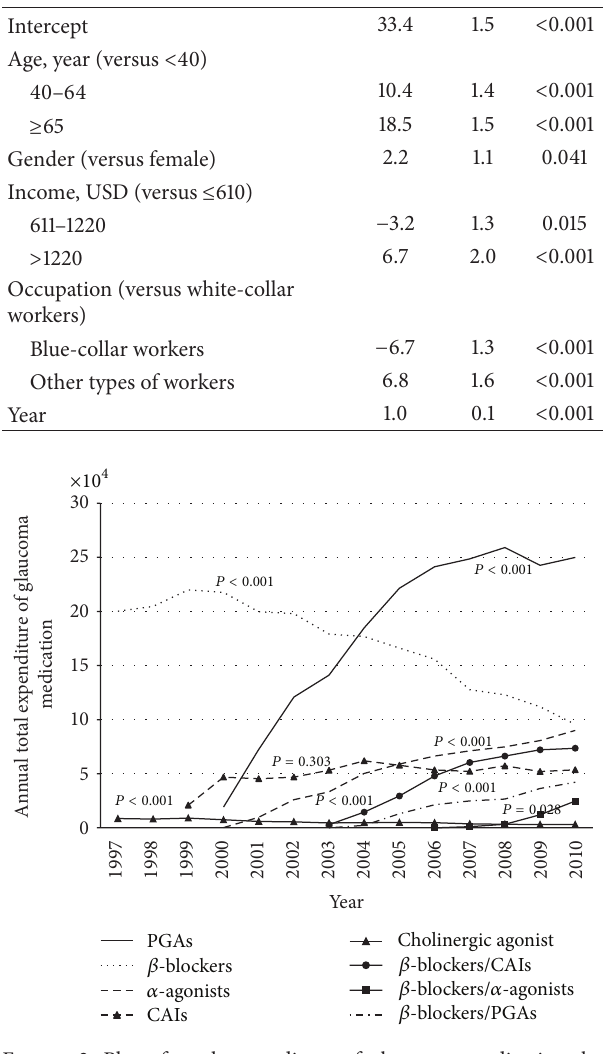
Figure 2: Plot of total expenditure of glaucoma medication, by medication